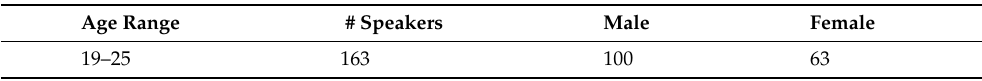
Table 9. Speaker age and gender